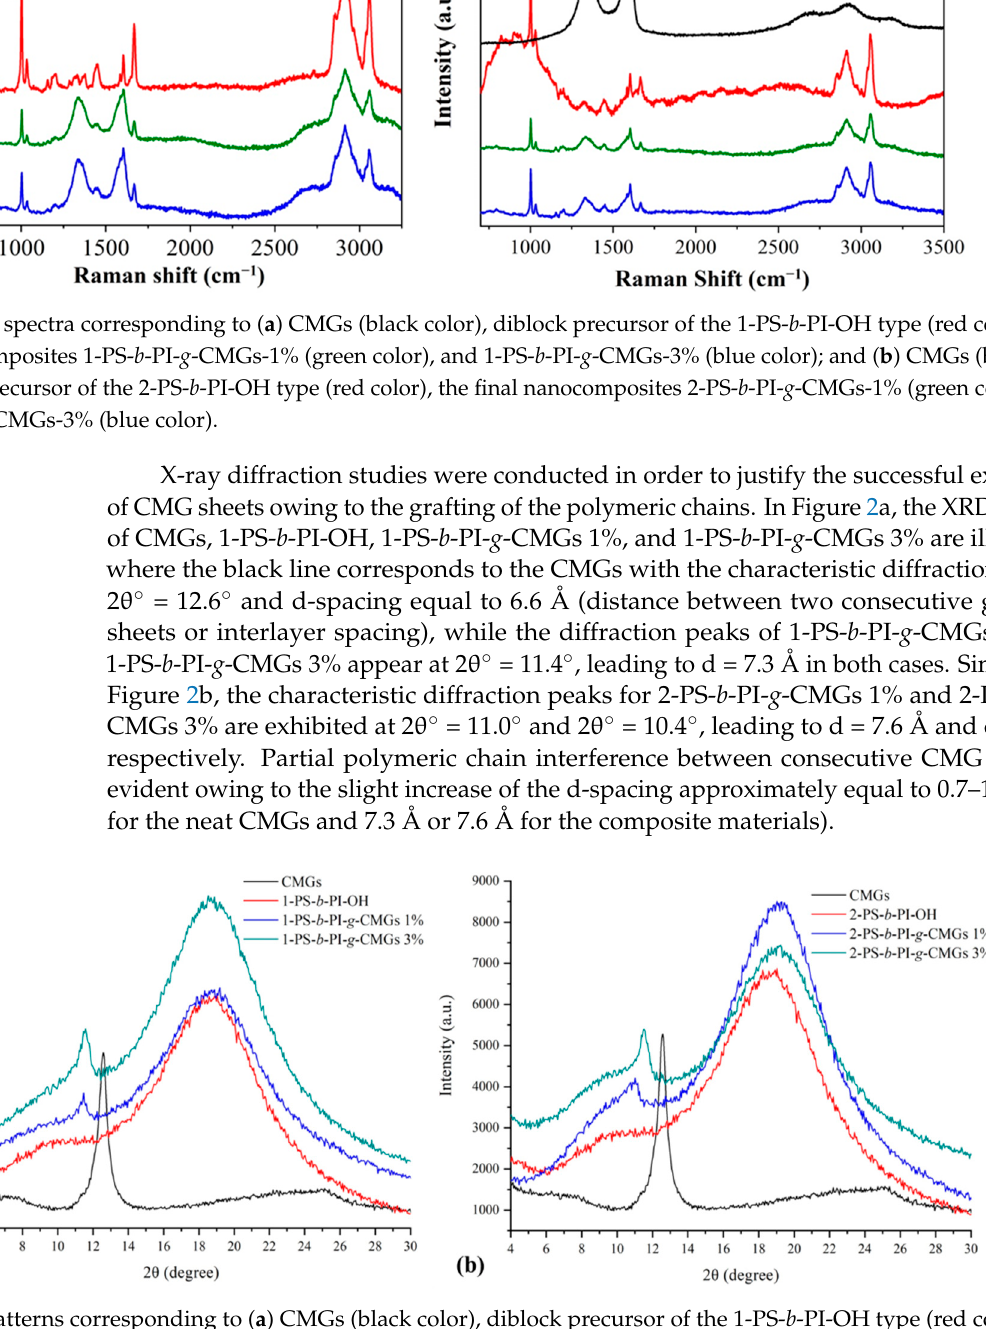
Figure 2. XRD patterns corresponding to ( a ) CMGs (black color), diblock precursor of the 1-PS- b -PI-OH type (red color), the final nanocomposites 1-PS- b -PI- g -CMGs 1% (blue color), and 1-PS- b -PI- g -CMGs 3% (green color); and ( b ) CMGs (black color), diblock precursor of the 2-PS- b -PI-OH type (red color), the final nanocomposites 2-PS- b -PI- g -CMGs 1% (blue color), and 2-PS- b -PI- g -CMGs 3% (green color).